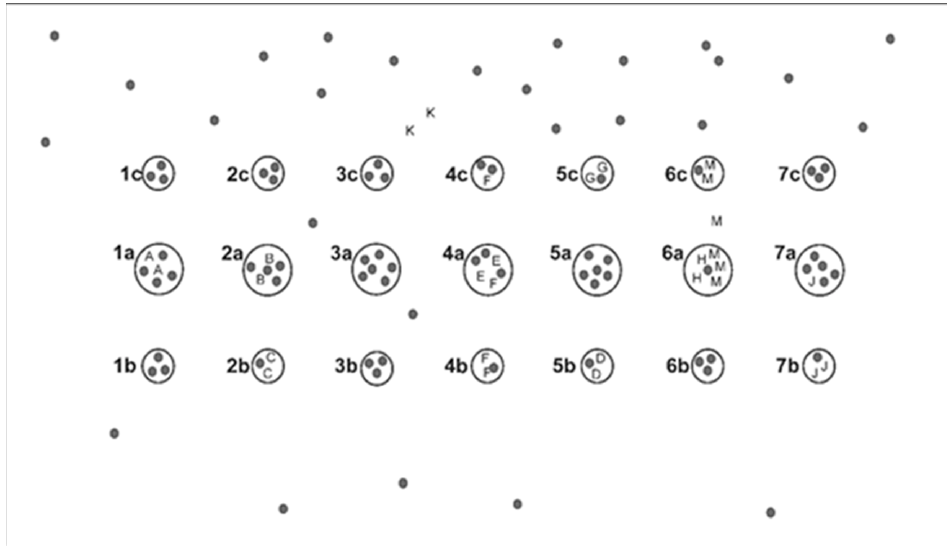
Figure 2. Distribution of European aspen ( Populus tremula L.) clones (individuals with the same MLGs) in the aspen site. Encircled are circular sampling plots of aspen juveniles. The ramets of the same clone are designated by the same letters (A, B, C, D, E, F, G, H, J, K, or M), and unique multilocus genotypes are shown as grey dots. Putatively maternal aspen trees are marked with dots outside of the circular plots.